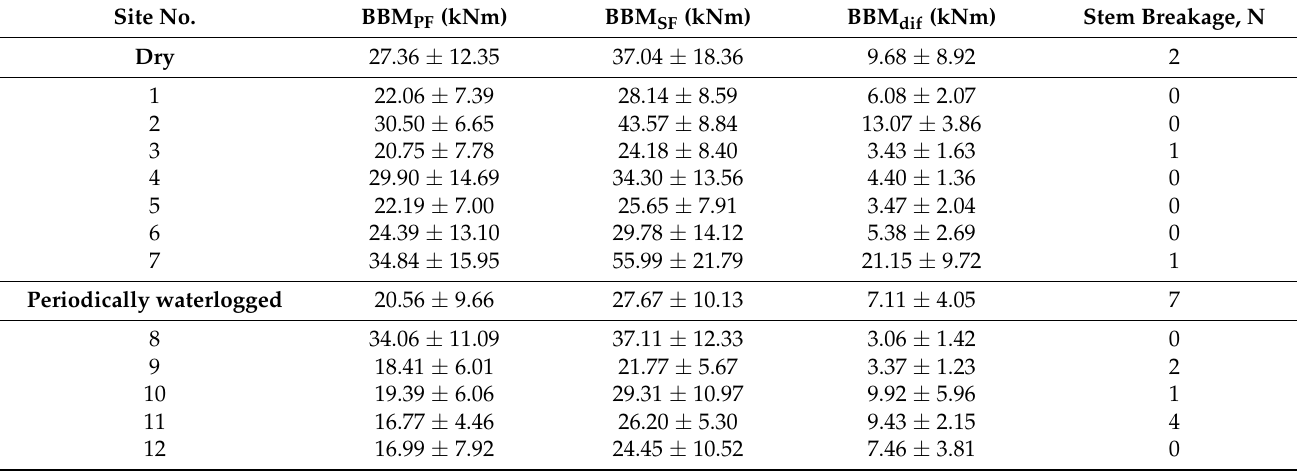
Table 2. Mean ( ± standard deviation) basal bending moment of birch stems at primary (BBM PF ) and (BBM SF ) secondary failures and difference (BBM dif ) between BBM PF and BBM SF , and the number of broken trees in each sampled site. Site No.